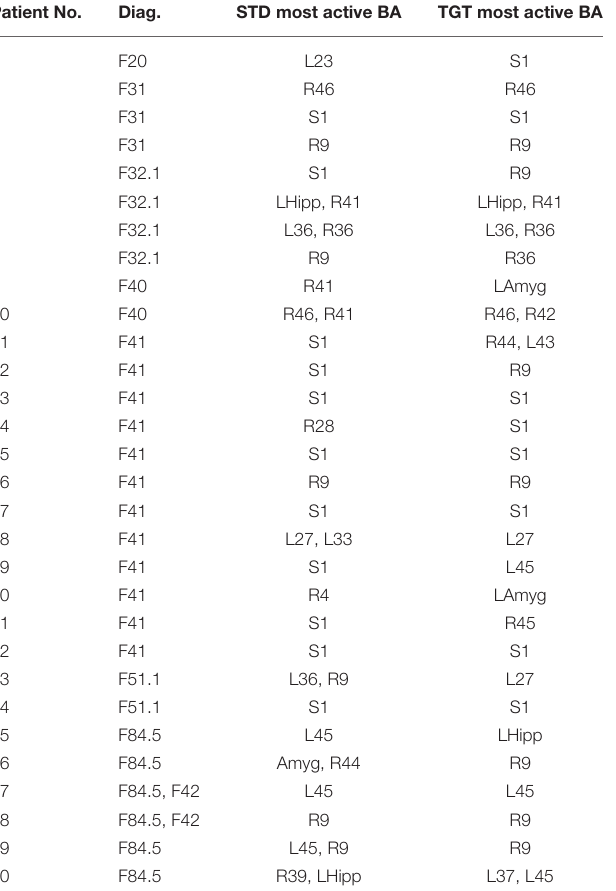
TABLE 2 | The ι for the most active BA in particular patients during the P300 experiment for the STD and TGT responses obtained from the sLORETA quantitative